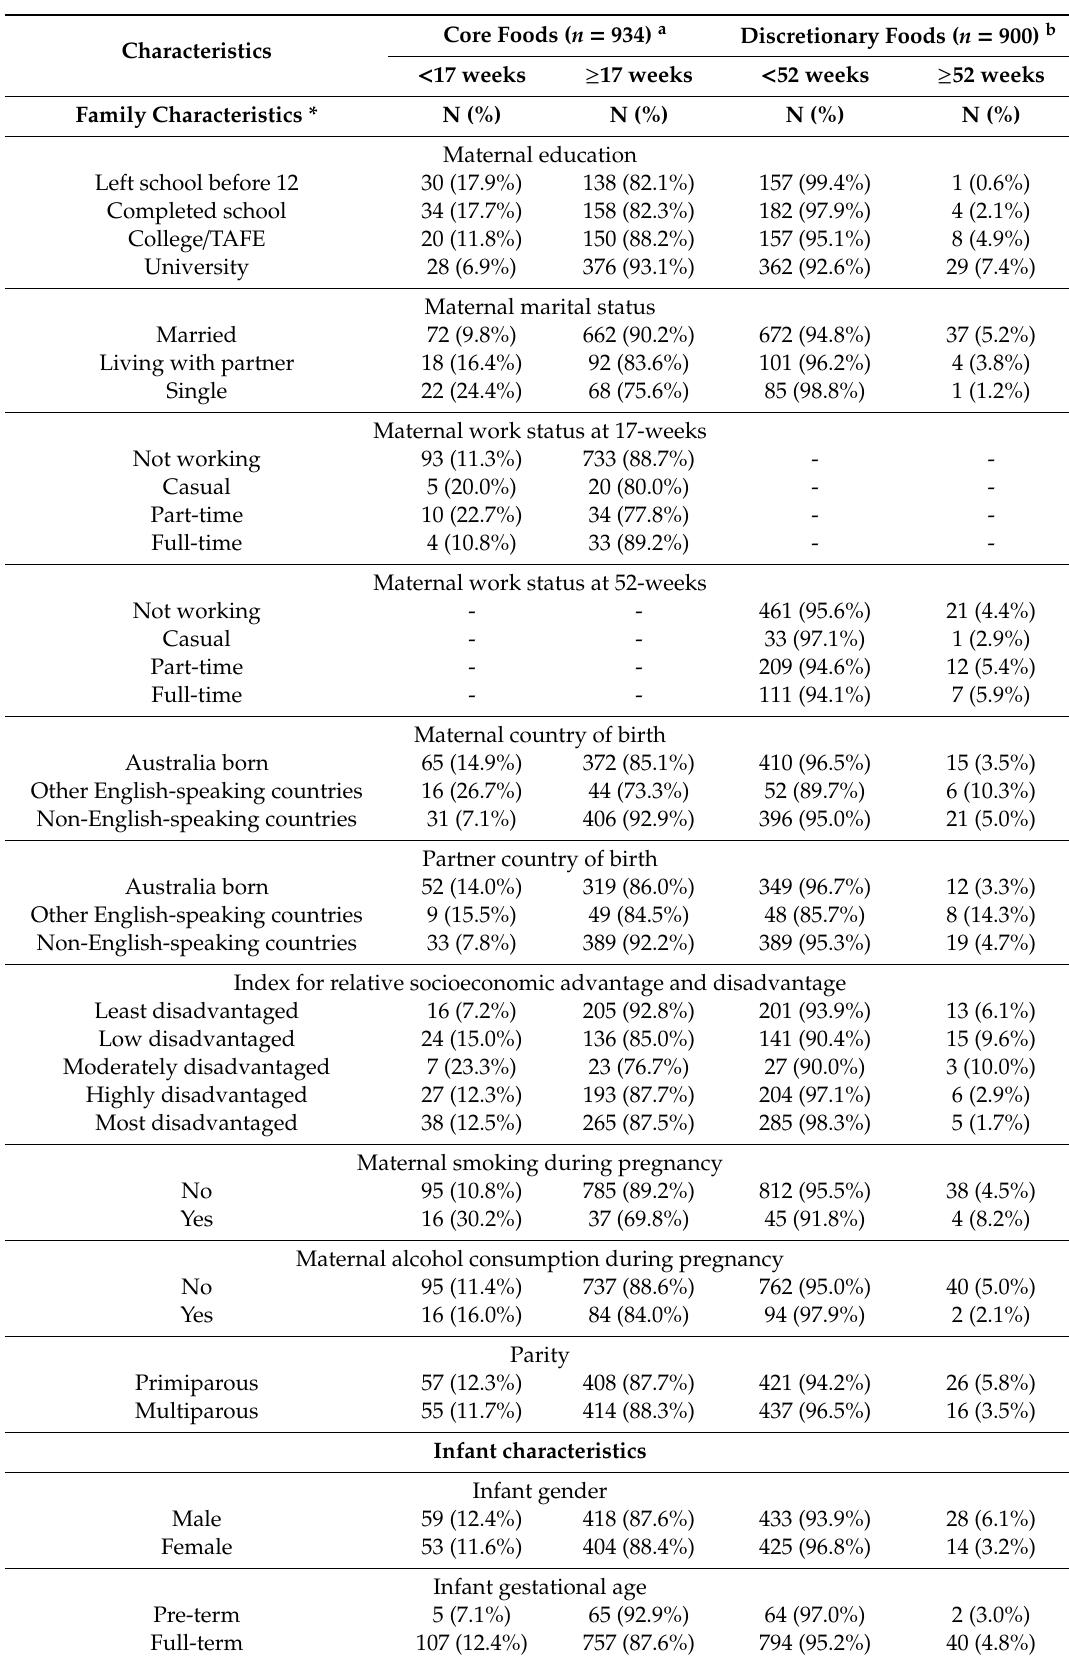
Table 1. Family and infant characteristics associated with early introduction of core and discretionary foods.